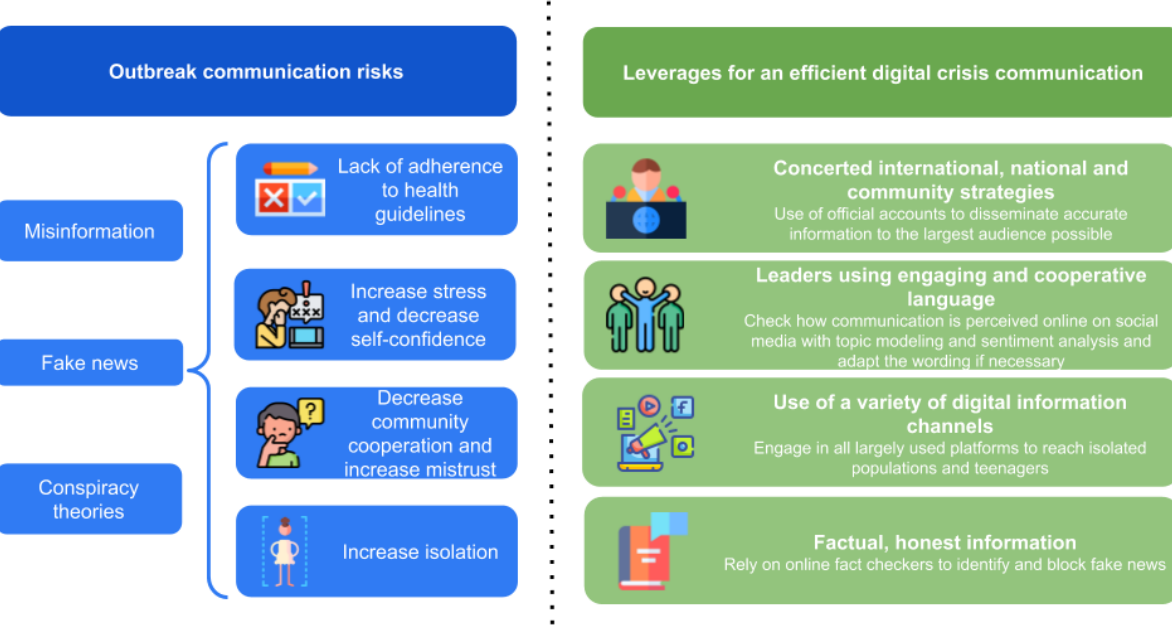
Figure 3. Communication risks and strategies during disease